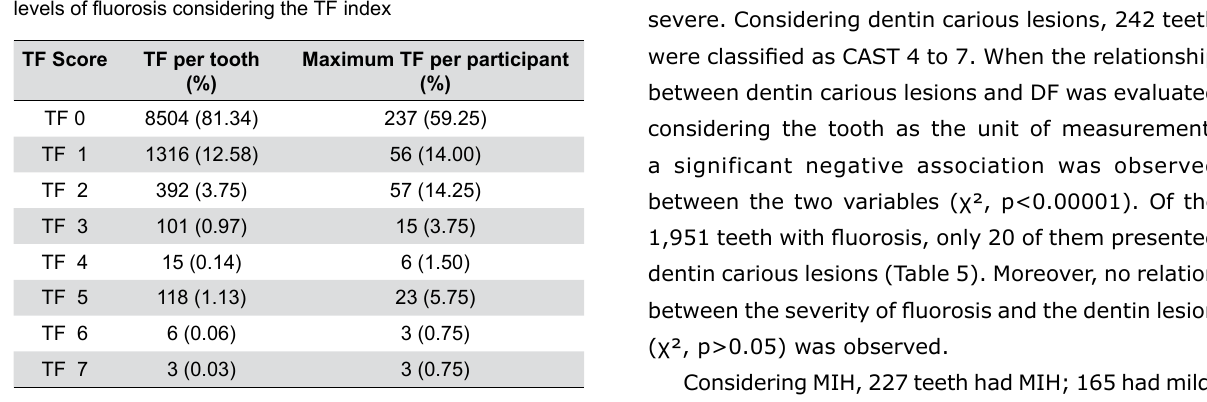
Table 2- Distribution of adolescents with and without fluorosis according to the information retrieved from the questionnaire related to the use of Questions